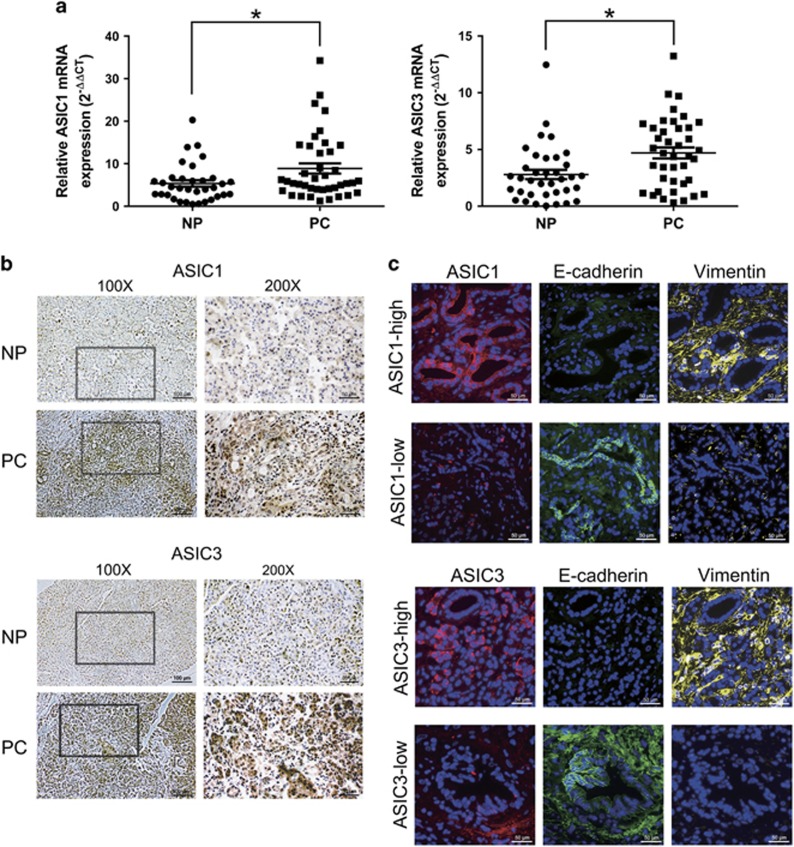
ASIC1 and ASIC3 are overexpressed and correlated to EMT marker in pancreatic cancer. (a) The mRNA expression of ASIC1 and ASIC3 in pancreatic cancer (PC) tissues when compared with matched adjacent noncancerous pancreatic (NP) tissues. Values were normalized against negative control in pH 6.4. Experiments were performed three times in triplicate and are presented as means±S.D. (*P<0.05). (b) Representative picture of immunohistochemical analysis showed the expression of ASIC1 and ASIC3 in pancreatic cancer tissues and matched adjacent noncancerous pancreatic tissues. (c) The representative immunofluorescence of ASIC1 (red), ASIC3 (red), E-cadherin (green), vimentin (yellow) and DAPI (blue) in pancreatic cancer tissues